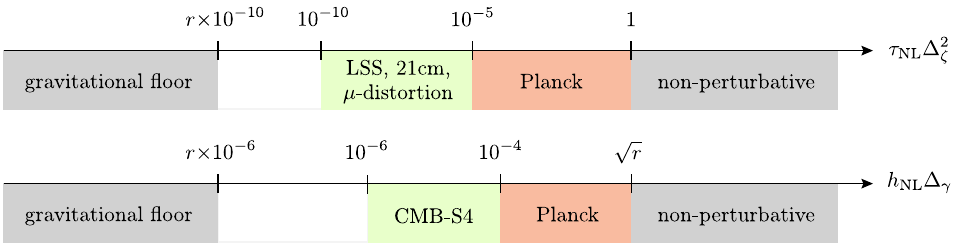
Figure 5 . Schematic illustration of current and future constraints on the scalar trispectrum (top) [89, 91{93] and tensor-scalar-scalar bispectrum (bottom) [81, 82, 94, 95] for local non- Gaussianity. The red and green regions correspond to the sensitivity levels of Planck [89] and forthcoming experiments, respectively. The \gravitational (cid:13)oor" refers to the guaranteed level of non-Gaussianity sourced by gravitational nonlinearities during in(cid:13)ation, while \non-perturbative" denotes the strongly non-Gaussian